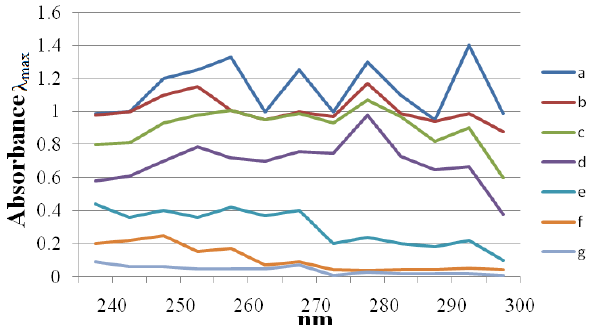
Figure 1. UV spectrophotometric sterol profile of C. albicans (NCIM3471) treated with, 0 (curve a), 1.5 (curve b), 3 (curve c), 6 (curve d), 12 (curve e) and 24 (curve f) µg/mL of synthesized compound 6f 1.5 (curve b), 3 (curve c), 6 (curve d), 12 (curve e) and 24 (curve f) µ g/mL of synthesized compound 6f and 25 (curve g) µg/mL of miconazole. Sterols were extracted from cells and spectral profiles and 25 (curve g) µ g/mL of miconazole. Sterols were extracted from cells and spectral profiles between between 240 and 300 nm were determined. 240 and 300 nm were